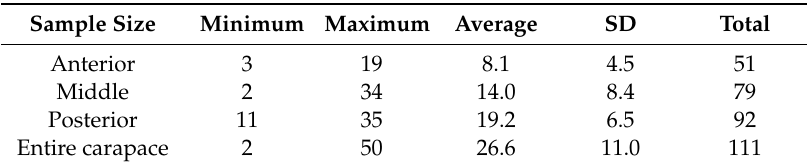
Table 1. Summary statistics on the number of nematode genera recovered from samples, sections and entire carapaces collected from loggerhead turtles nesting at St. George Island, Florida during the peak of the 2018 nesting season.